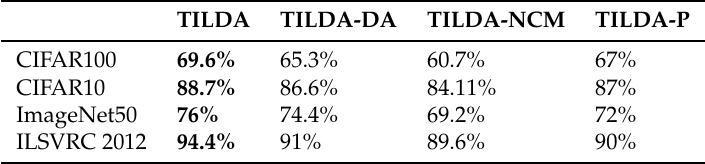
Table 1. Accuracy on CIFAR10/100, ImageNet50 and ImageNet ILSVRC 2012. TILDA uses the